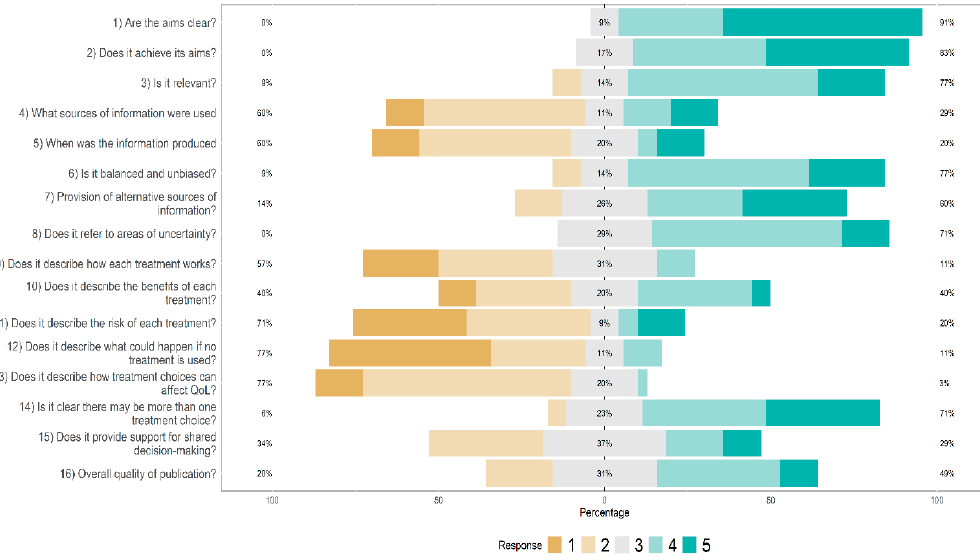
Figure 3. Distribution of DISCERN-scores combined and averaged across English websites (1 = low, 5 = high). Adapted from Charnock et al. [72].